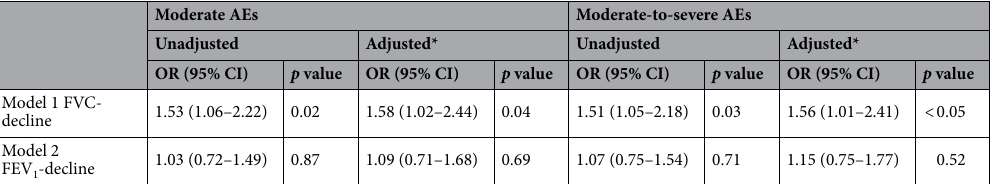
Table 4. Factors associated with exacerbation of ACO patients in univariable and multivariable logistic regression analysis. Univariable and multivariable logistic regression analyses of moderate AEs and moderate- to-severe AEs were performed. In the model 1, variables were selected from different factors of previous analyses (FVC-decline group vs. FVC-incline group and AEs “Yes” group vs. AEs “No” group). Compared to the FVC grouping of model 1, FEV 1 grouping (FEV 1 -decline and FEV 1 incline group) was selected as variables in model 2. After adjusted, FVC-decline group of model 1 was associated with moderate (OR 1.65) and moderate-to-severe AEs (OR 1.65), which was not shown in FEV 1 grouping of model 2. ACO asthma-chronic obstructive pulmonary disease overlap, AEs acute exacerbations, BMI body mass index, CI confidence